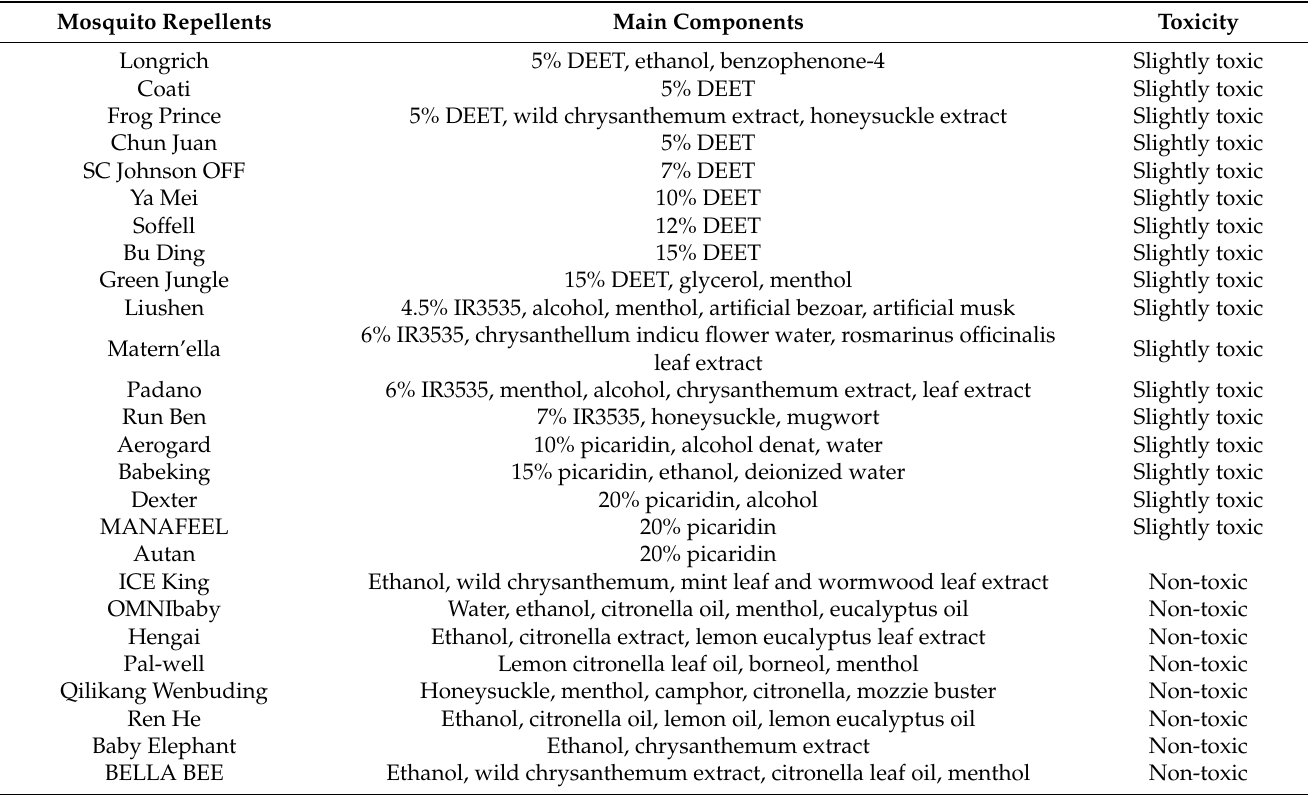
Table 2. Manufacturer, properties, main components, and toxicity of selected mosquito